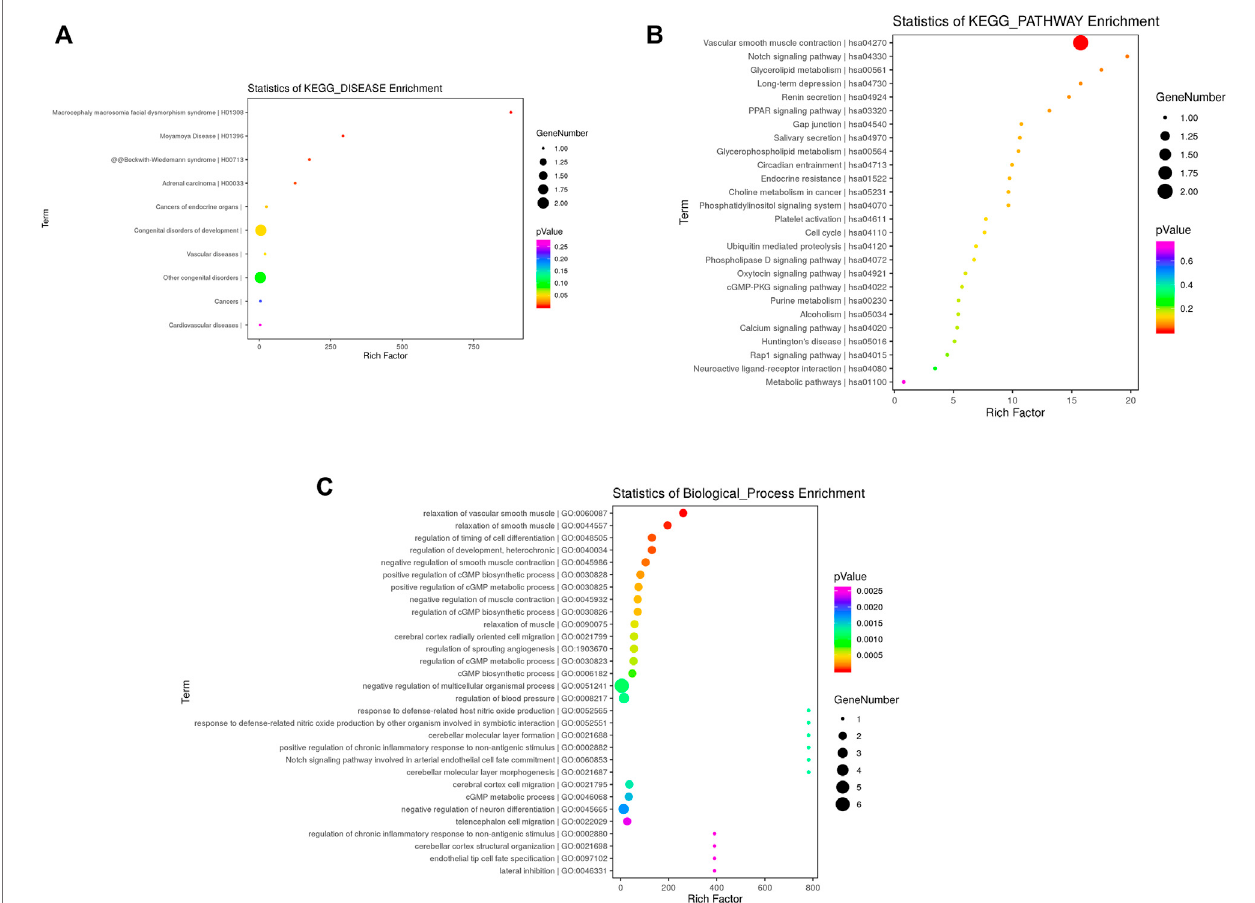
FIGURE 3 | Functional enrichment analysis of differential methylation regions annotated genes in CTDs vs. controls KEGG enrichment analysis in disease (A) and pathway (B) ; (C) Top 30 terms of biological process (BP).